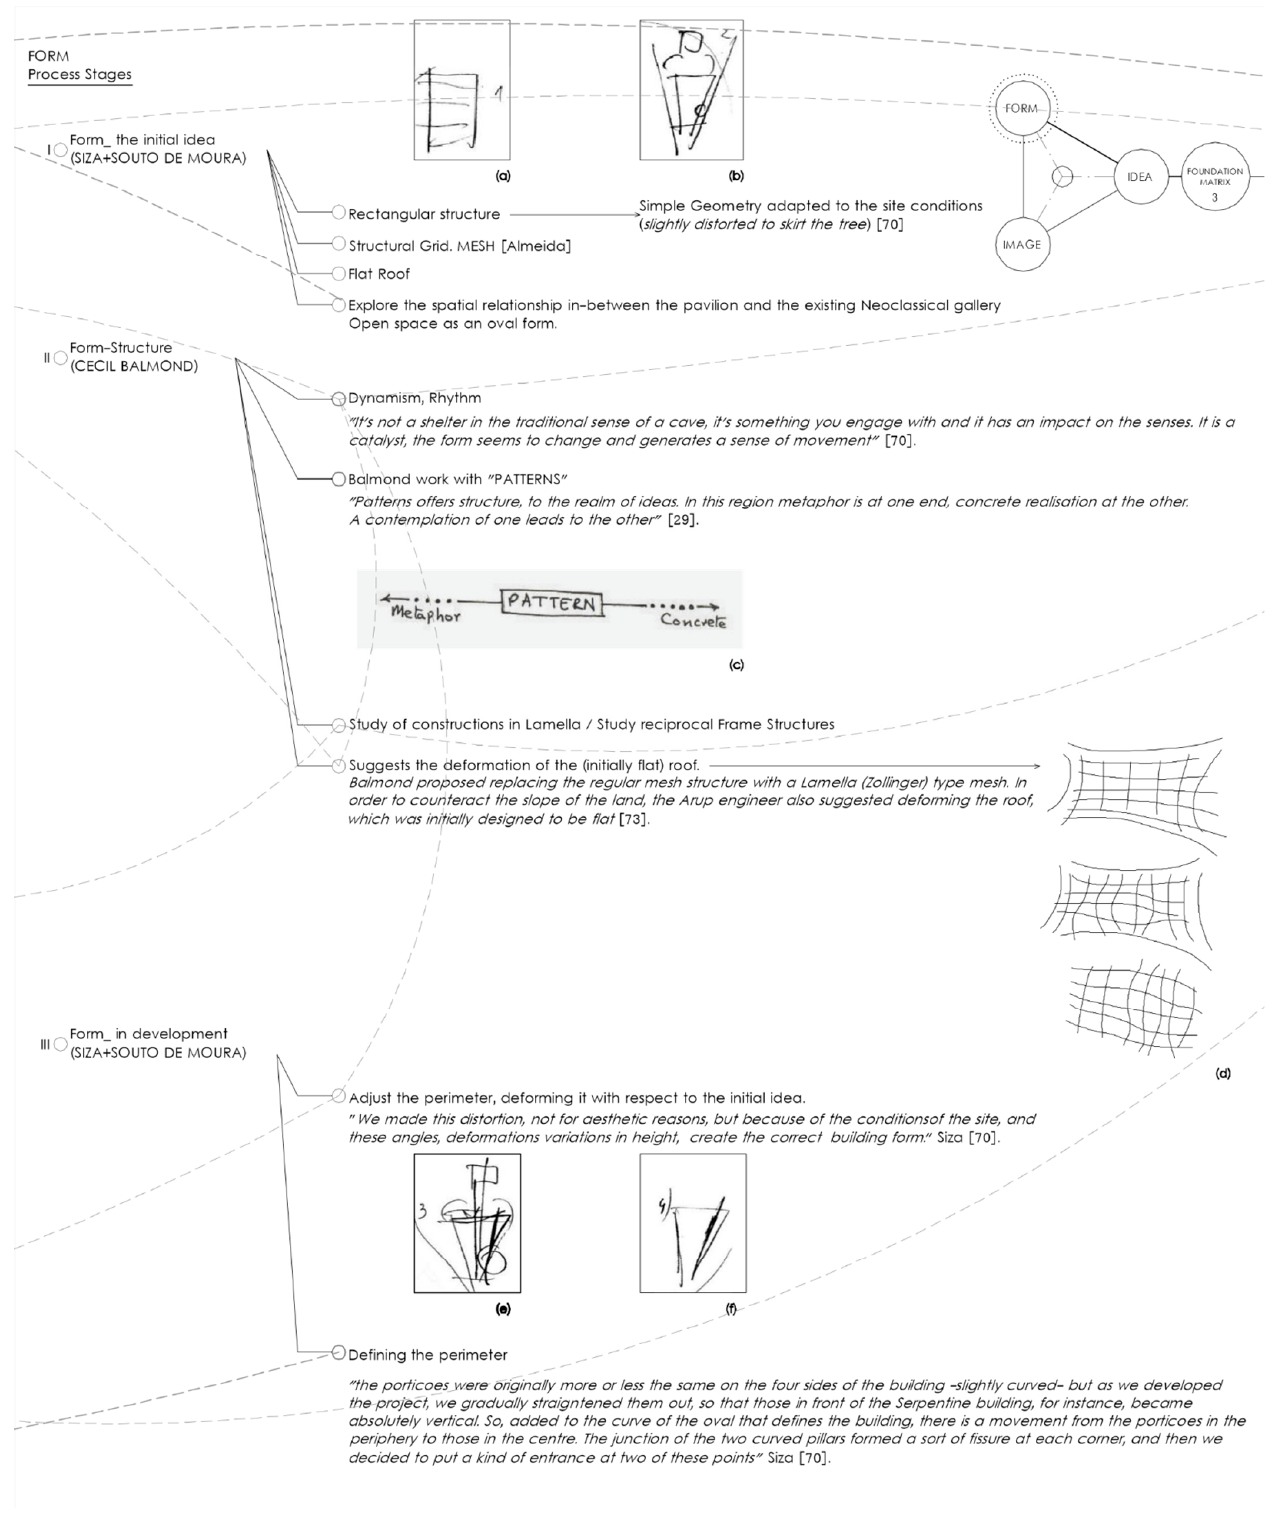
Figure 8. Foundation matrix 3. ( a , b , e , f ) Souto de Moura sketches cited in [72]; ( c ) Balmond scheme [29]; ( d ) del Río-Calleja based on Balmond sketches [72].